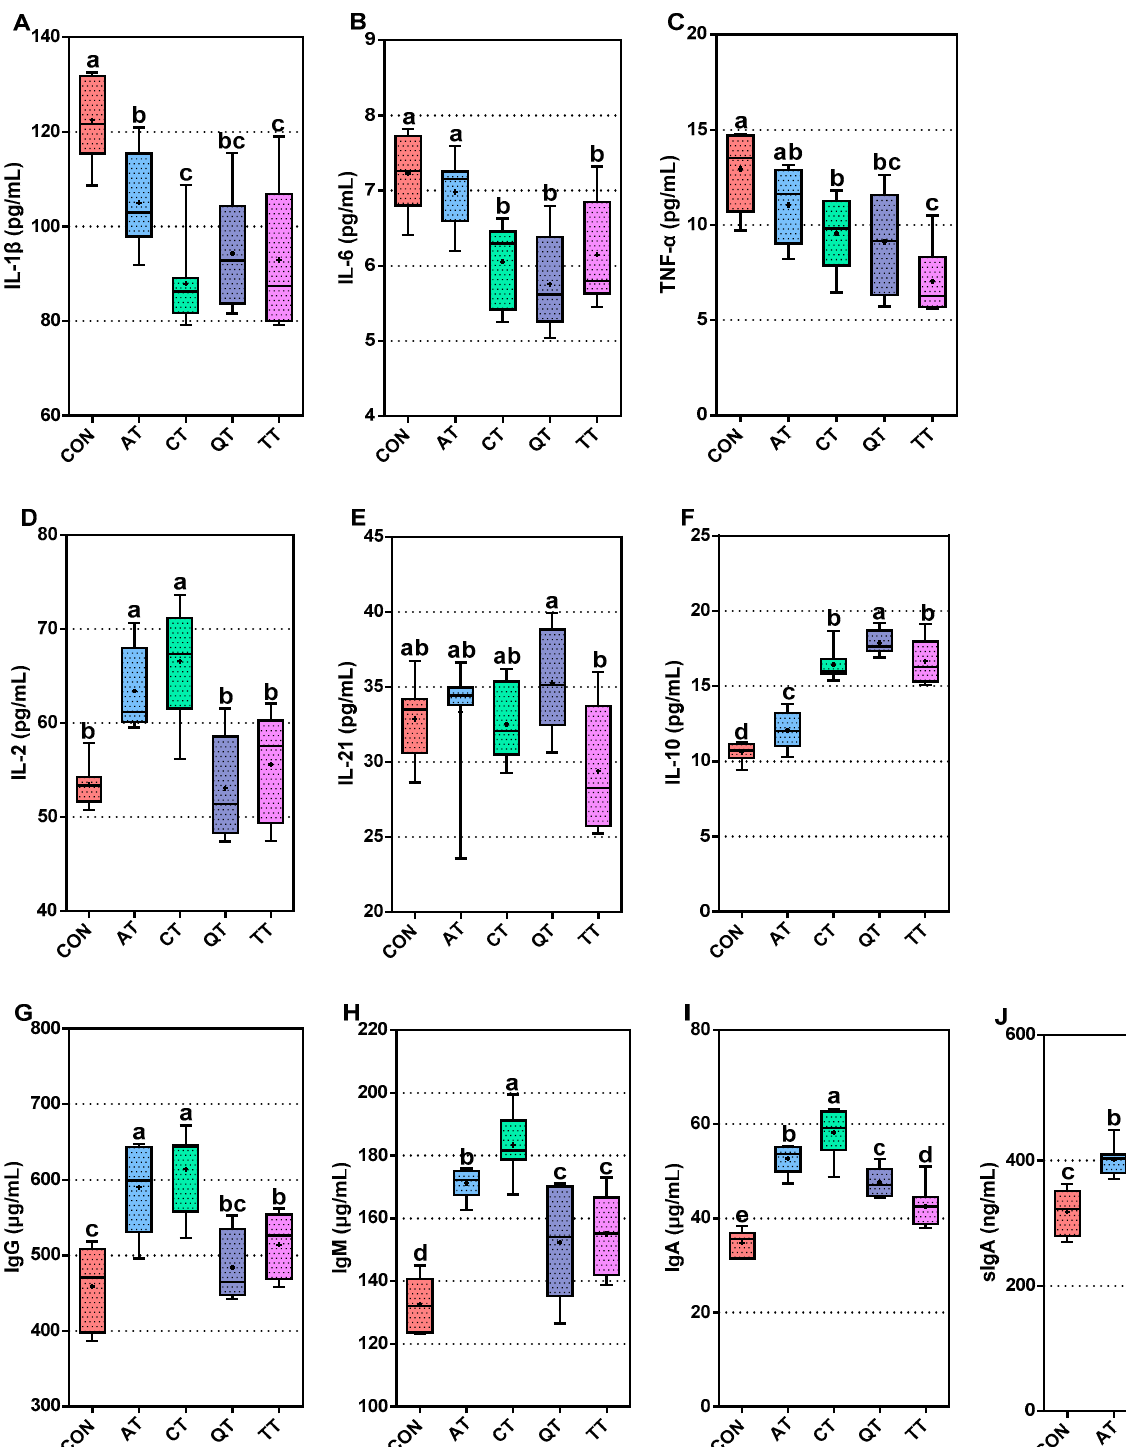
Figure 2. Effects of adding different tannins to the diet on the immunity. ( A ) Interleukin-1 β , IL-1 β ; ( B ) interleukin-6, IL-6; ( C ) tumor necrosis factor- α , TNF- α ; ( D ) interleukin-2, IL-2; ( E ) interleukin- 21, IL-21; ( F ) interleukin-10, IL-10; ( G ) immunoglobulin G, IgG; ( H ) immunoglobulin M, IgM; ( I ) immunoglobulin A, IgA; ( J ) secretory immunoglobulin A, sIgA. Different letters (a, b, c, d and e) indicate significant differences ( p < 0.05), while the same letter indicates no significant differences ( p > 0.05). CON, control; AT, Acacia mearnsii tannin; CT, Castanea sativa tannin; QT, Schinopsis lorenzii tannin; TT, Caesalpinia spinosa tannin.